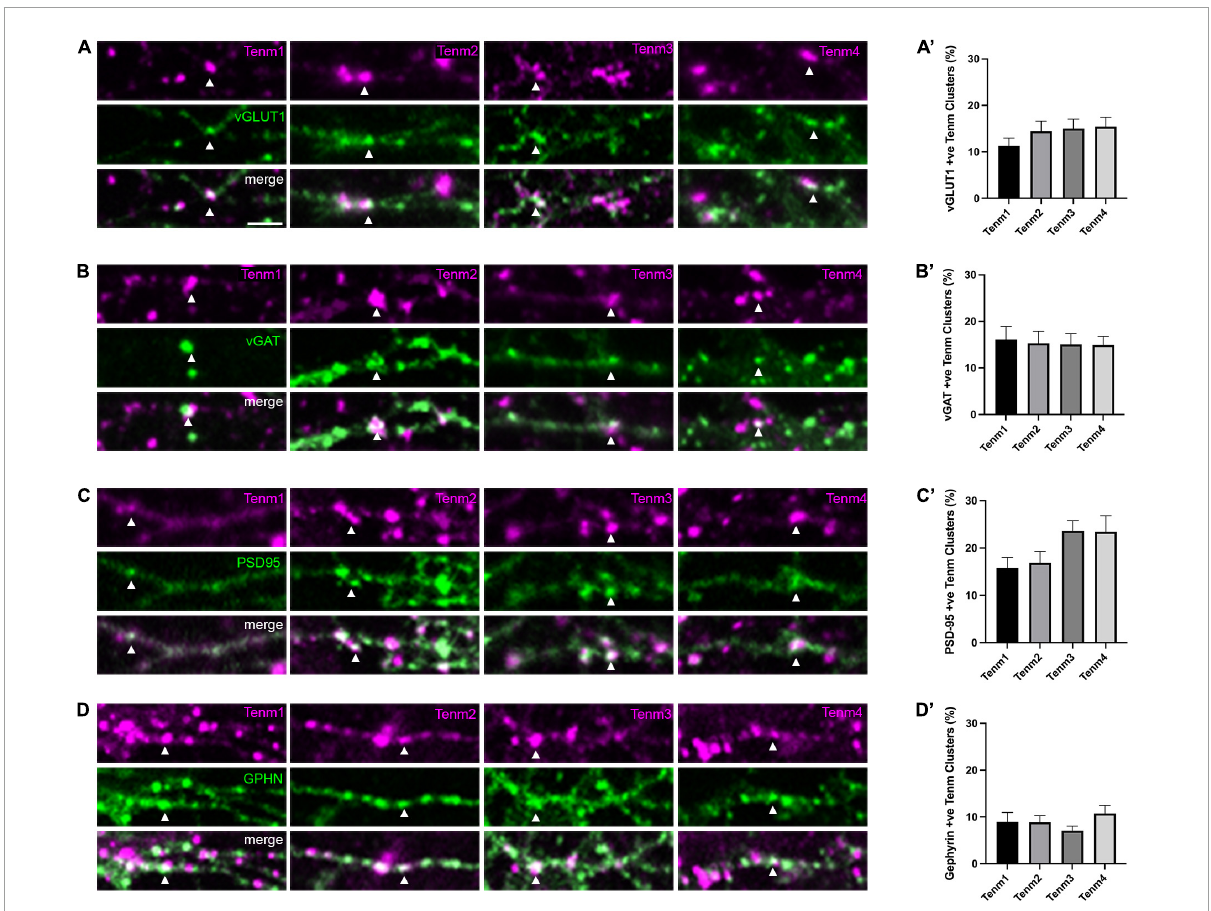
FIGURE2 Teneurin distribution across different synaptic sites. Immunocytochemistry detection of (A) vGLUT, (B) vGAT, (C) PSD95, and (D) Gephyrin in dissociated neurons transfected with EGFP-tagged teneurin paralogues. In each panel, one example colocalisation is indicated by the arrowhead. Graphs on the right show quantification of colocalisation. (A (cid:48) –D (cid:48) ) Levels of teneurin colocalisation with vGLUT, vGAT, and PSD-95 are similar (10–20%), while co-localisation with Gephyrin is slightly lower (below 10%). Data represents mean ± SE based on samples with at least 12 cells/condition pooled from a least three different experiments. One-way ANOVA with Dunnett’s multiple comparison test was performed between all paralogues ( p < 0.05). Scale bar, 5 µ m (all